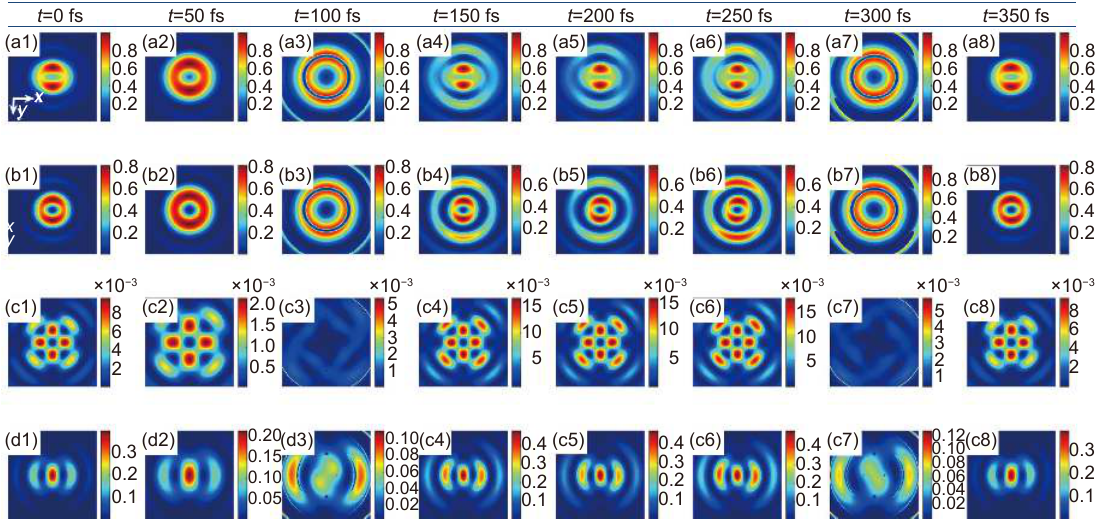
Fig. 2 | The focused field distributions of linearly polarized light with the first-order vortex at different temporal intervals. The total in- tensity distributions | E t | 2 ( a1 – a8 ) as well as the transverse | E x | 2 ( b1 – b8 ), | E y | 2 ( c1 – c8 ) and the longitudinal | E z | 2 ( d1 – d8 ) field components in the x-y plane with the periodic time of t = 0 fs (a1–d1), 50 fs (a2–d2), 100 fs (a3–d3), 150 fs (a4–d4), 200 fs (a5–d5), 250 fs (a6–d6), 300 fs (a7–d7), and 350 fs (a8–d8). The color scale indicates the magnitude of the normalized intensity. The sizes for all of the images are 2 λ ×2 λ . The other parameters are chosen as pulse width T = 5 fs, a laser beam with a center wavelength of 532 nm, central angular frequency ω 0 = 3.543×10 15 s –1 , beam size σ 0 = 2 cm, topological charge m = 1, and NA =